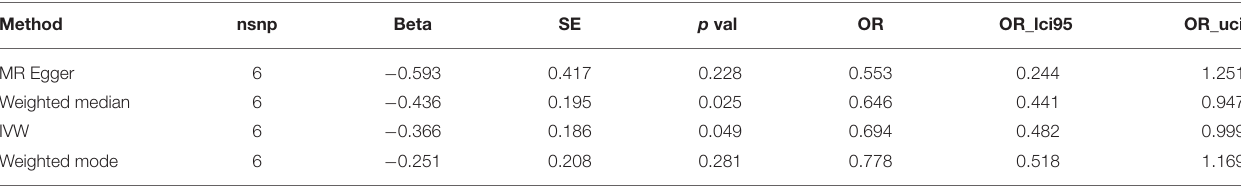
TABLE 5 | The putative causal association of plasma omega-3 levels with low back